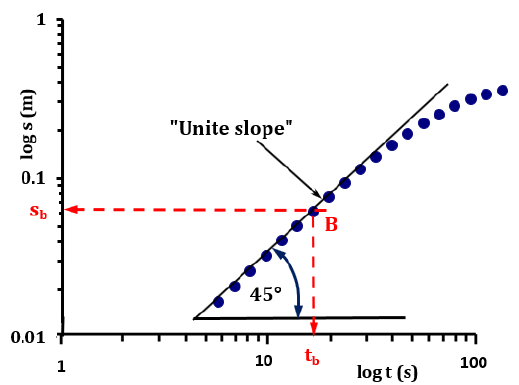
Figure 2. Graph log s vs. log t at the beginning of the pumping test when the water is pumped only from the wellbore’s own volume.